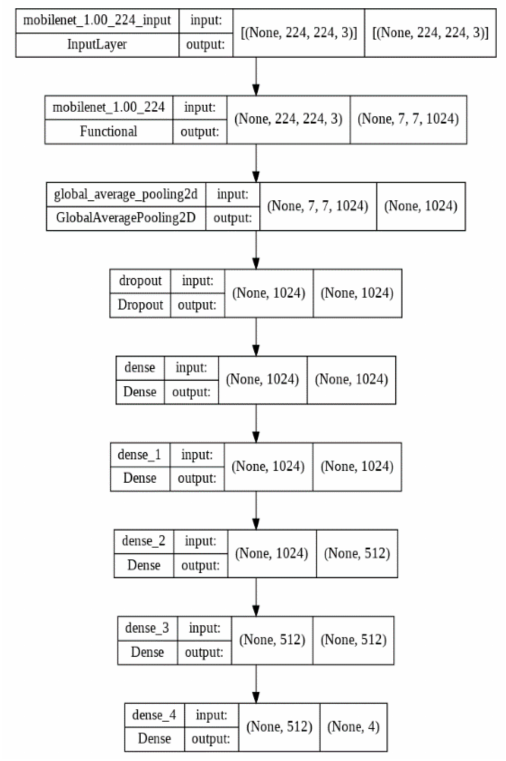
Figure 2. MobileNet V2 architecture for fine-tuning.